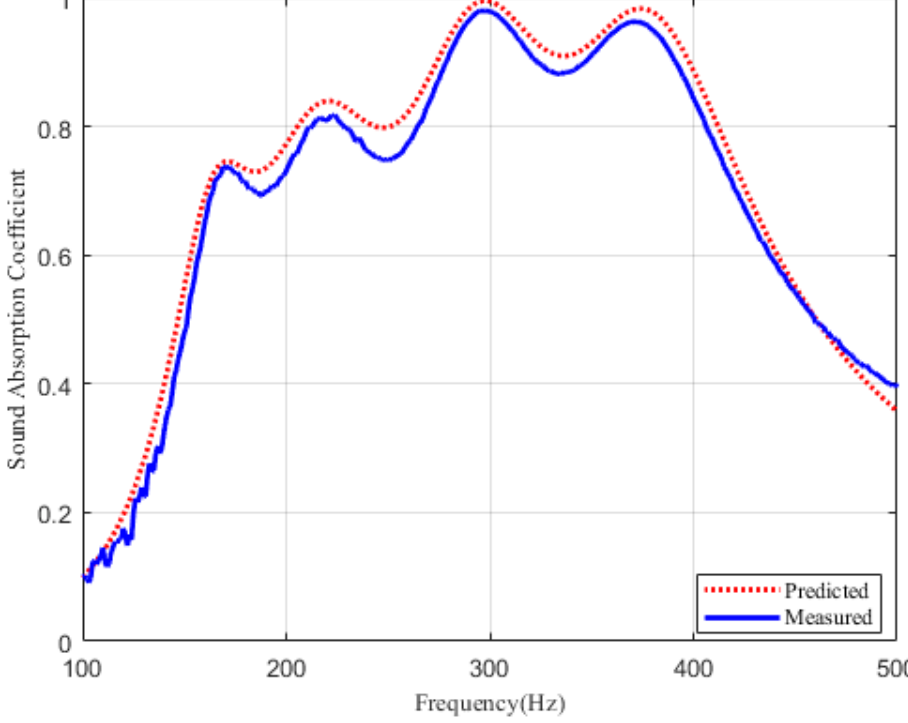
Figure 7. Sound absorption coefficient of the four parallel-arranged PPAs for 150–450 Hz. Red dotted line: predicted results. Blue solid line: measured results.